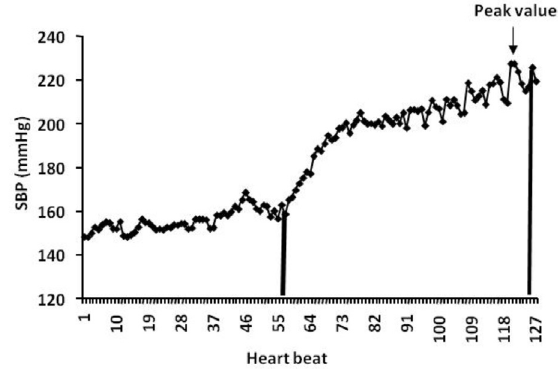
Figure 1 - Systolic blood pressure (SBP) measured during each heart beat in a representative hypertensive subject performing a set of leg extension exercises until exhaustion at 40% of 1RM (repetition maximum).